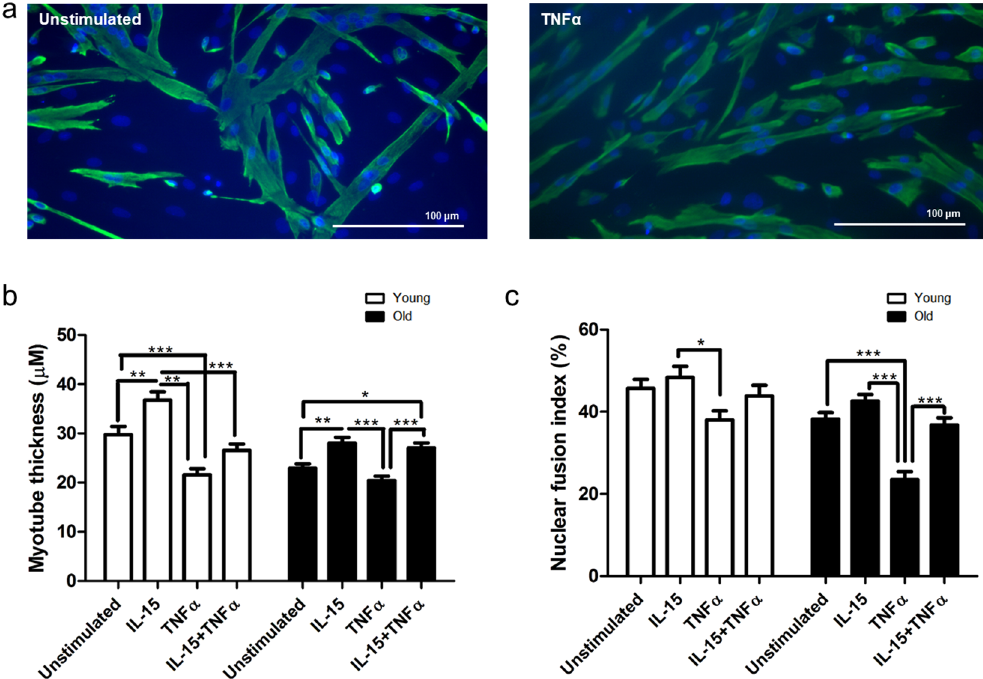
Figure 2. Recombinant IL-15 stimulation of differentiating primary human myoblasts partially reverses TNF α - induced inhibition of myogenic differentiation of cells from both young and old individuals. Subconfluent myoblasts were switched to differentiation medium containing the indicated recombinant cytokines (IL-15, 25 ng/mL; TNF α , 1 ng/mL) for 8 d. Media were renewed every 2 d. Myotubes were fixed, immunofluorescence stained for desmin and DAPI and imaged on an epifluorescence microscope. ( a ) Representative images at 20x magnification. ( b ) Myotube thickness data represents the mean ± SEM of 450 total measurements taken at 63x magnification from 90 myotubes per treatment condition (from 3 biological replicates). ( c ) Nuclear fusion index data represents the mean ± SEM values from 45 images taken at 20x magnification (from 3 biological replicates). * p < 0.05, ** p < 0.01, *** p < 0.001 vs. unstimulated condition by 2-way ANOVA with